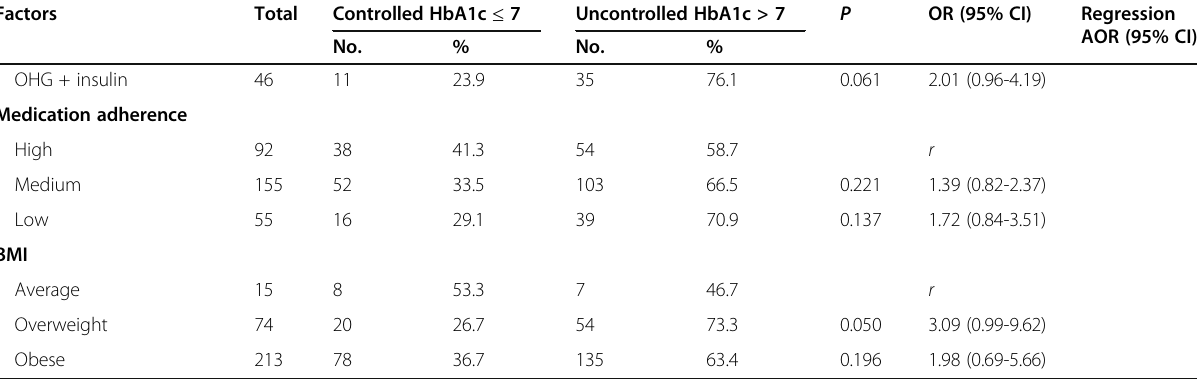
Table 1 Relationship between controlled blood glucose and some factors of the studied subjects (Continued)